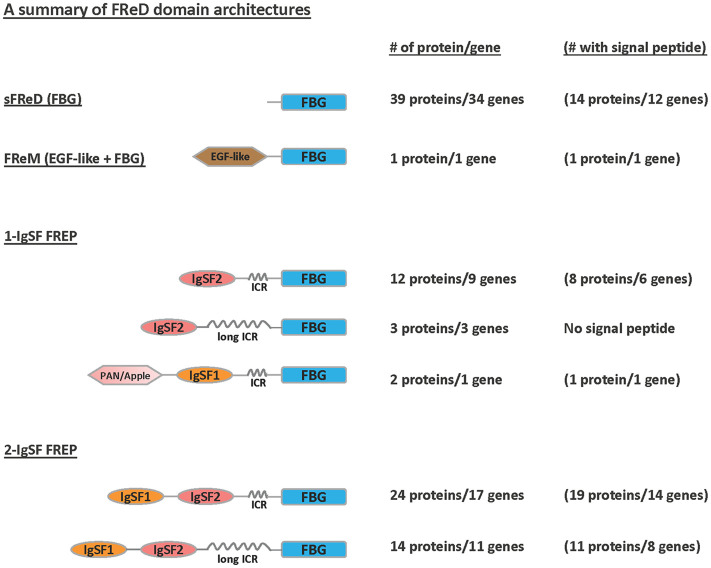
Predicted domain architectures of FReD proteins in B. glabrata BB02.Three main categories are indicated: sFReD (FBG), FReM (EGF-like + FBG), 1-IgSF FREP (1 IgSF loop + FBG), and 2-IgSF FREP (2 IgSF loops + FBG). FBG: fibrinogen domain; EGF-like: epidermal growth factor (EGF)-like domain; PAN/Apple: PAN/Apple domain; IgSF1: Immunoglobulin Superfamily Member 1; IgSF2: Immunoglobulin Superfamily Member 2; ICR: interceding region (<150aa) between IgSF and FBG domains that form coiled coils; long ICR: long interceding region (150~320aa).